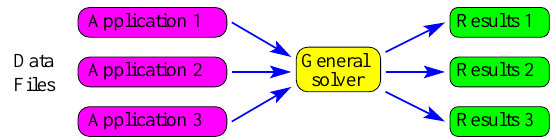
Figure 2. Computational organization with classical coordinates. Figure 3. Computational organization with minimal